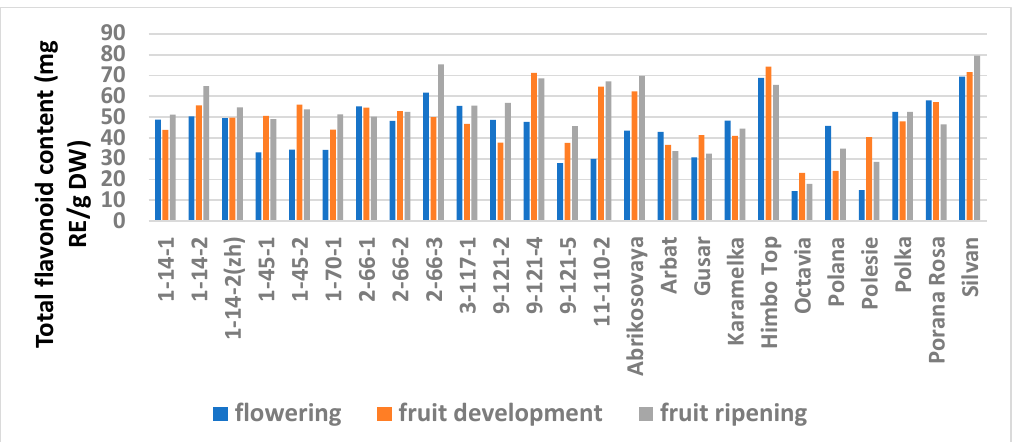
Figure 2. Effect of different harvest periods (phenophase) on total flavonoid content in raspberry leaves. Statistical analysis of the data is presented in Table S6.